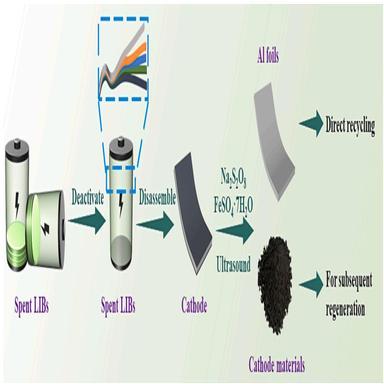
Flow sheet for the separation of cathode materials and Al foil from spent LIBs in USFH.